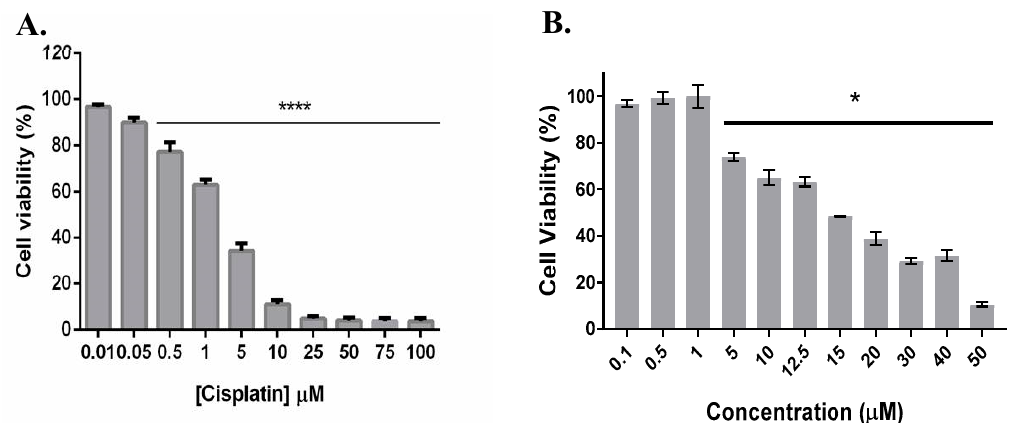
Figure 5. Cytotoxicity of cisplatin in A2780 ( A ) and HCT116 ( B ) cell lines after 48 h of incubation (1.9 ± 0.2 µ M and 15.6 ± 5.3 µ M for A2780 and HCT116 cell lines, respectively). Cell viability was determined using the MTS assay. Data normalised against the control (0.1% ( v / v ) DMSO) and expressed as the mean ± SEM of three independent assays. * p < 0.05; **** p < 0.005.